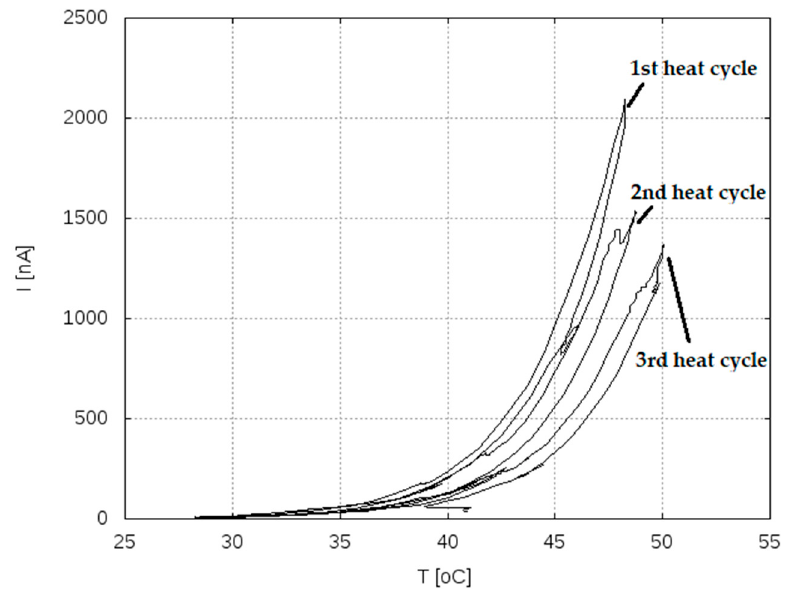
Figure 8. The “tempering” effect. After every heat cycle the total current is getting lower at higher temperatures. This can be used to “prepare” the chambers for field applications where temperature fluctuations are high.